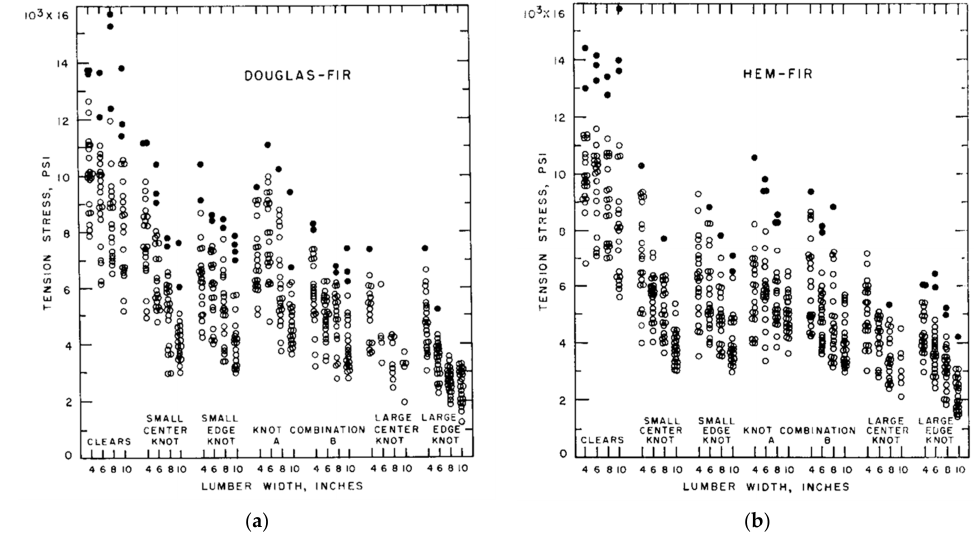
Figure 27. Plots of the measured tensile strengths for two-inch (5 cm) dimension lumber of four different nominal widths and seven different grades cut from two types of tree: ( a ) Douglas Fir and ( b ) Hem-Fir. From [155].